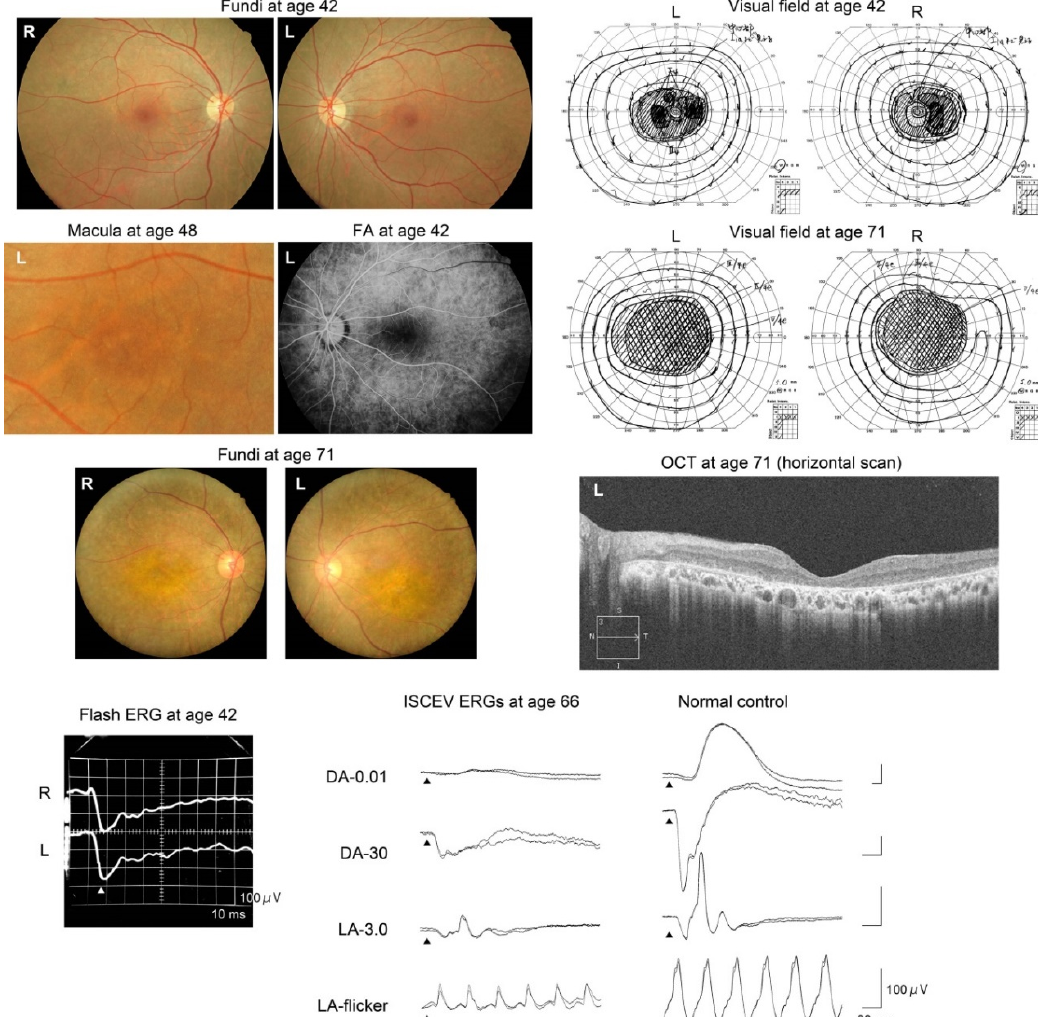
Figure 5. Results of fundus photography, fluorescein fundus angiography (FA), Goldmann kinetic visual field testing, OCT imaging, and ISCEV ERGs in Patient 3 (Kinki-69-1159). This patient had both homozygous DRAM2 variants, c.8_10delGGT, p.Trp3del and a heterozygous EYS variant, p.Gly843Glu.